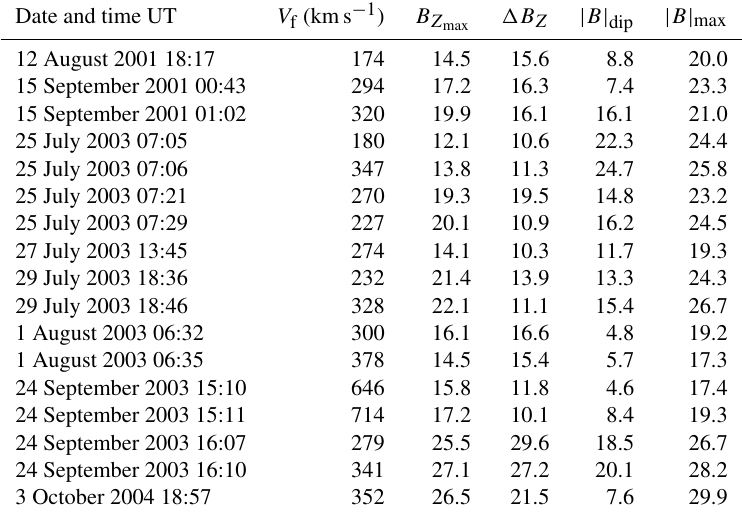
Table 2. Parameters of the DFs observed in dipolarization events from our database, namely, the values of the propagation velocity of the DFs ( V f ) in the ( XY ) plane, maximum values of the B Z field ( B Z ), the amplitude of the B Z field variation ( (cid:49)B Z ) associated with the DFs, max magnetic field value in the dip region observed before the DFs ( | B | dip ) and the maximum values of the magnetic field at the DFs ( | B | max